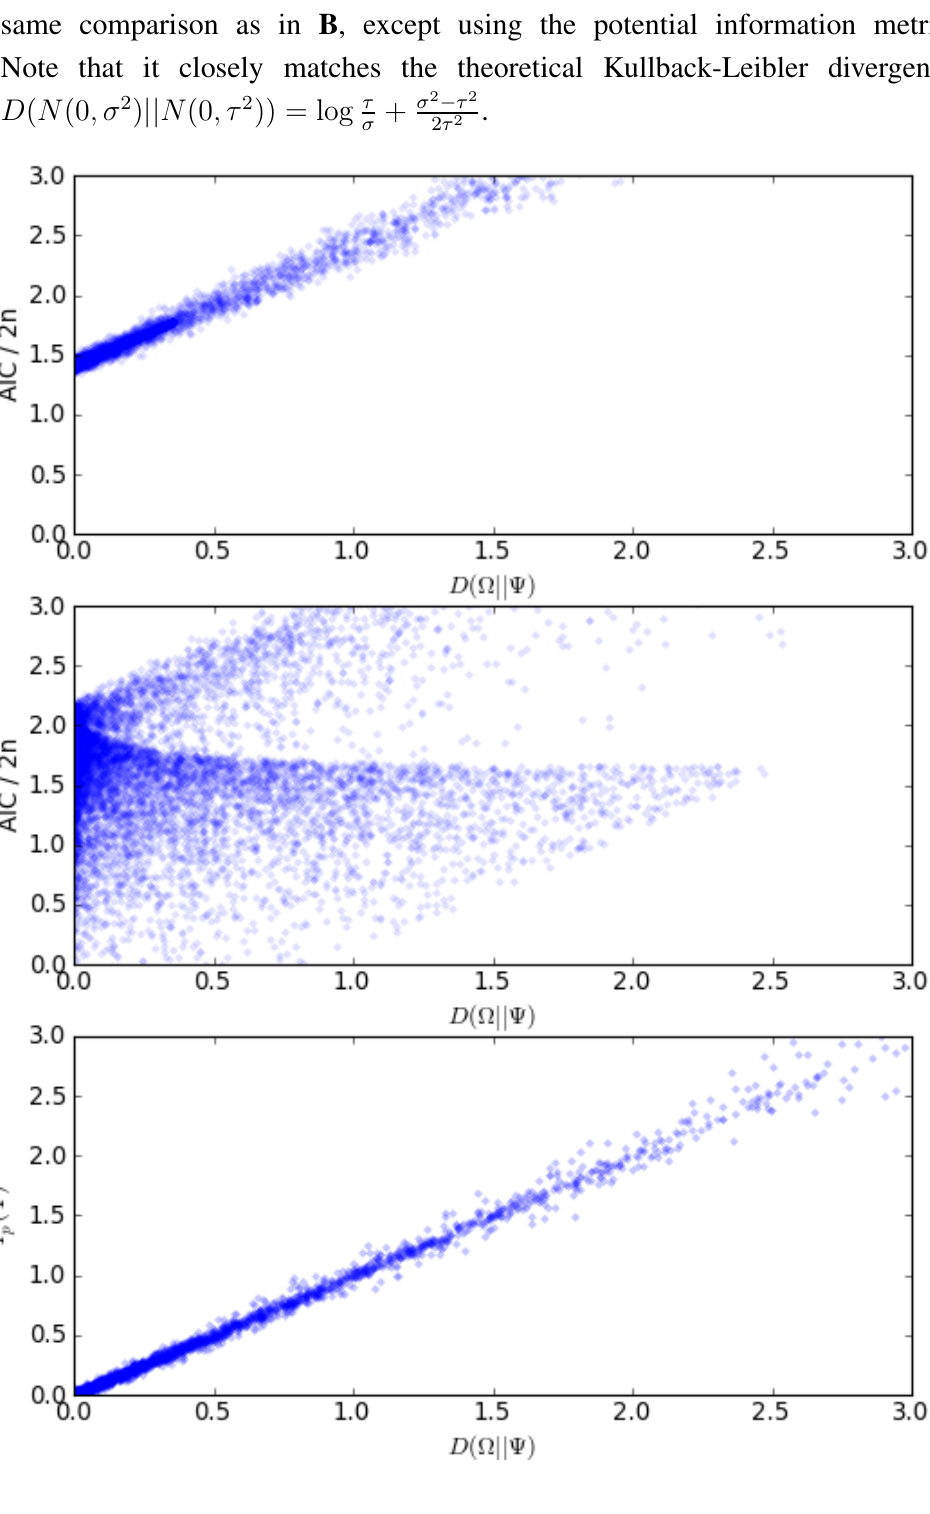
Figure 2. Comparing AIC and Potential Information to the Theoretical Kullback-Leibler Divergence. A. Comparison of AIC values vs. Kullback-Leibler divergence for a sample of 10,000 different models, with the true distribution fixed to the unit normal distribution N (0 , 1) . Each model was a normal distribution N (0 , τ 2 ) where the standard deviation τ was drawn uniformly on the interva (0 . 1 , 2) . For each model, the AIC was calculated using n = 1000